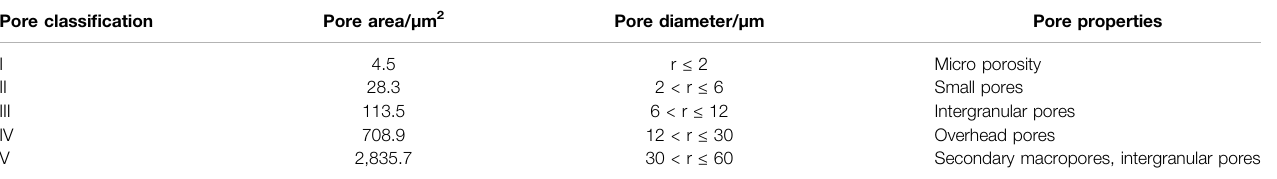
TABLE 3 | Classi fi cation of loess pore microstructure. Pore classi fi